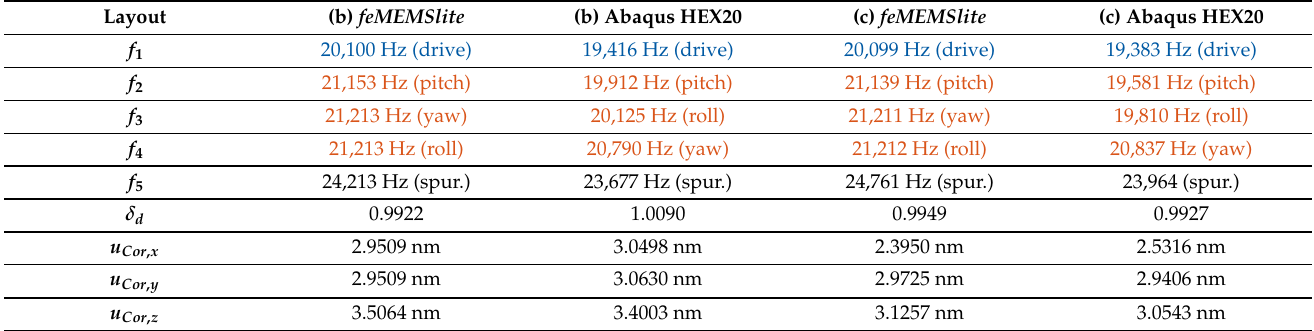
Table 4. Validation of the optimized layouts: comparison with Abaqus